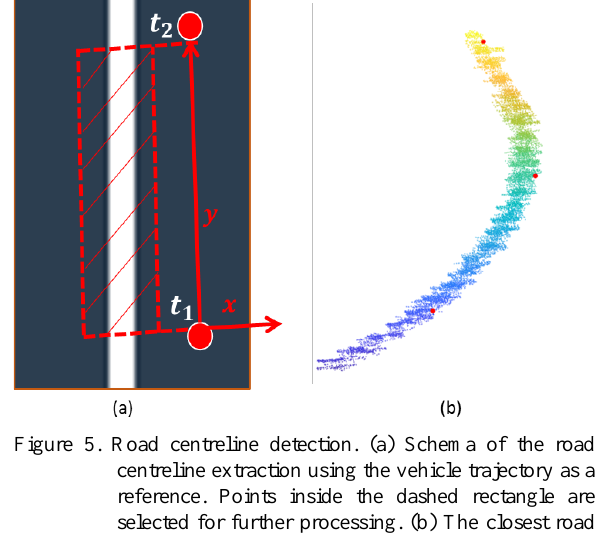
Figure 5. Road centreline detection. (a) Schema of the road centreline extraction using the vehicle trajectory as a reference. Points inside the dashed rectangle are selected for further processing. (b) The closest road marking point to each trajectory point is extracted.